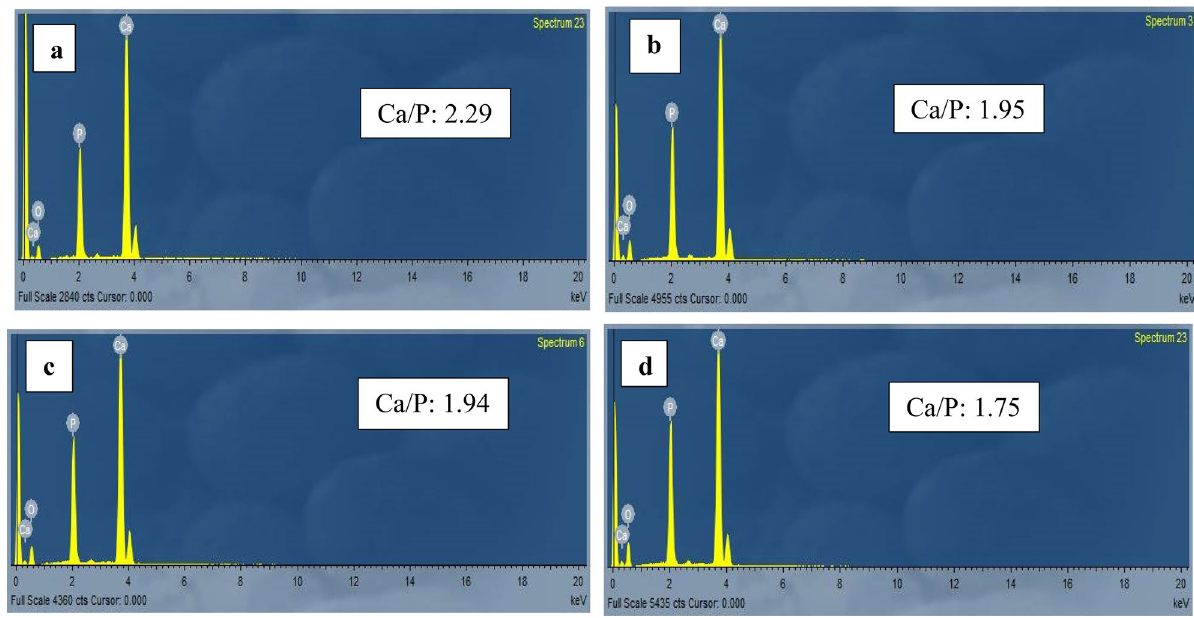
Figure 3. EDX of the remineralized specimen showing the Ca/P ratio at 150 µm: ( a ) prepared TCS, ( b ) CPP- ACP, ( c ) SDF-KI, and ( d ) control